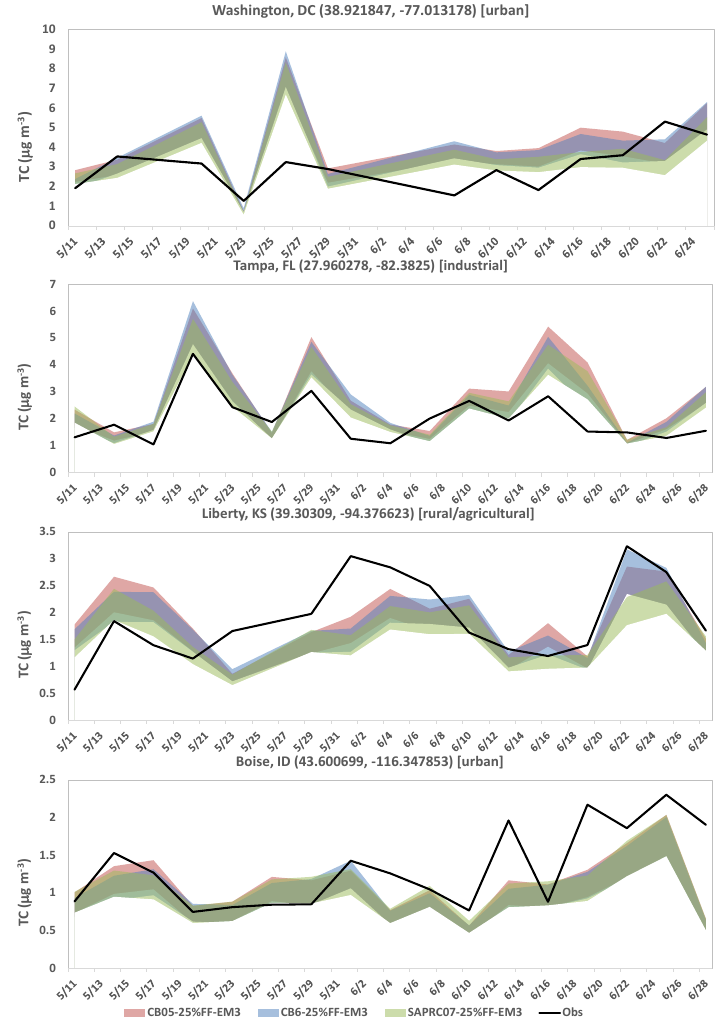
Figure 8. Time-series plots of STN TC vs. simulated TC at selected sites from sensitivity simulations of different gas-phase mechanisms. The colored bands represent the range of OC values for ratios 1.4 to